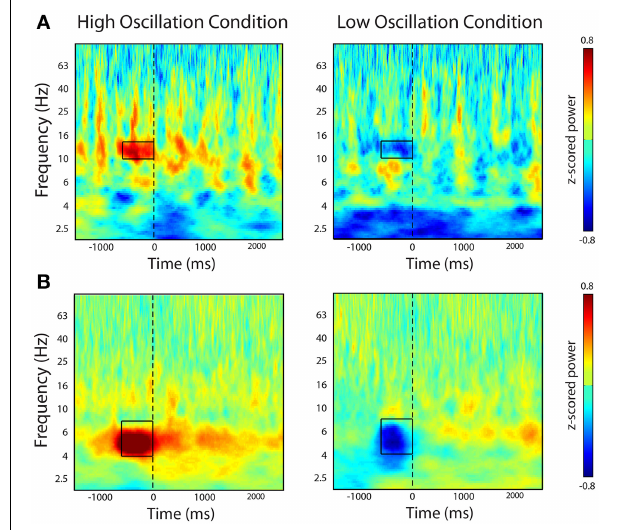
FIGURE 4 | Post-hoc time-frequency analysis of spectral power during contingent conditions. The figure shows time-frequency power spectra averaged across all word presentations during the bciFR task. (A) In one participant, we selectively triggered word presentation on increases (left-panel) or decreases (right-panel) of an alpha oscillation. (B) In a second participant, we triggered word presentation on increases (left-panel) or decreases (right-panel) of a theta oscillation. Word presentation is indicated by the dashed line at t = 0. Color represent average z -scored power at every time point and every frequency for all word presentations during the contingent